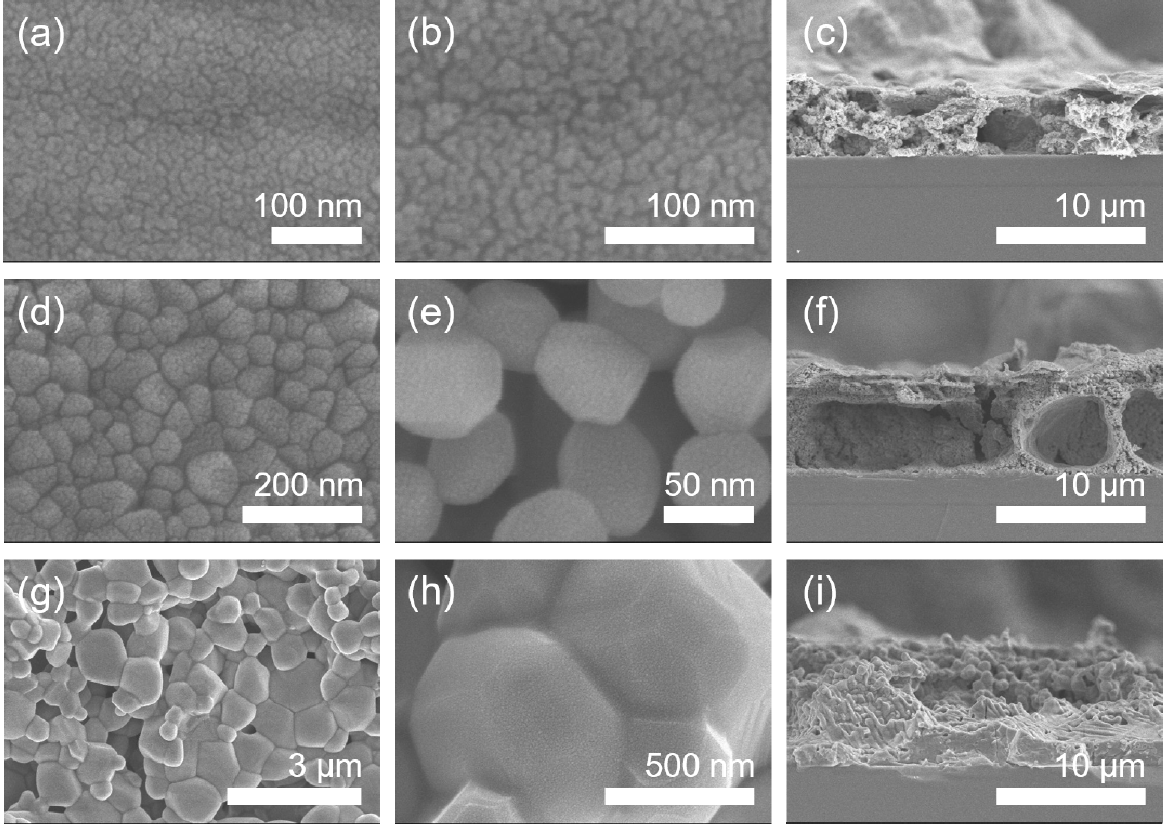
Figure 6. FE-SEM micrographs of the manganese oxide (Mn 3 O 4 ) films. ( a ) The low-magnification and ( b ) high-magnification top-view images and ( c ) cross-sectional image of 400 °C-calcinated films on SiO 2 /Si substrates under an inert atmosphere of Ar. ( d ) The low-magnification and ( e ) high-magnification top-view images and ( f ) cross-sectional image of 800 °C-calcinated films under an inert atmosphere of Ar. ( g ) The low-magnification and ( h ) high-magnification top-view images and ( i ) cross-sectional image of 1000 °C-calcinated films under an inert atmosphere of Ar.